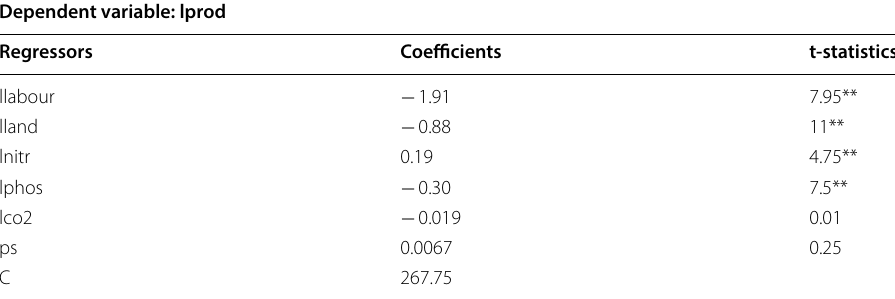
Table 7 Long-run estimates based on the Johansen cointegration Source : Author’s